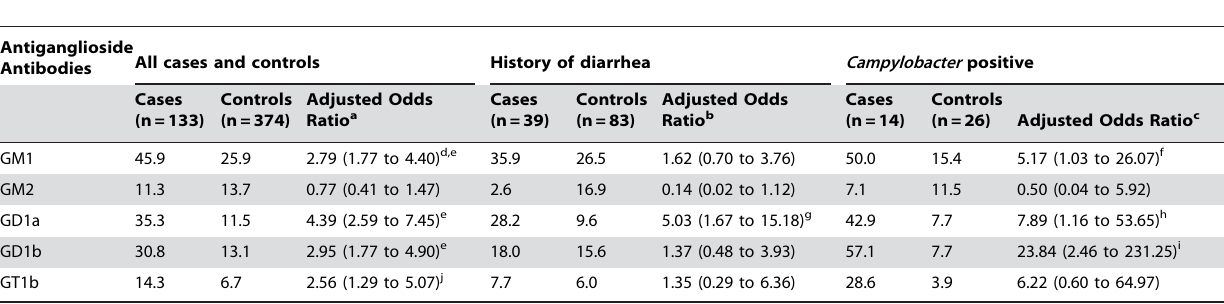
Table 3. Odds of having IgM serum antibodies against GMI, GM2, GD1a, GD1b, and GT1b gangliosides in Guillain-Barre´ Syndrome cases and patient-controls for all cases and controls, for patients reporting diarrhea, and for patients excreting Campylobacter , the Arab Republic of Egypt, April 2001 through September 2003.